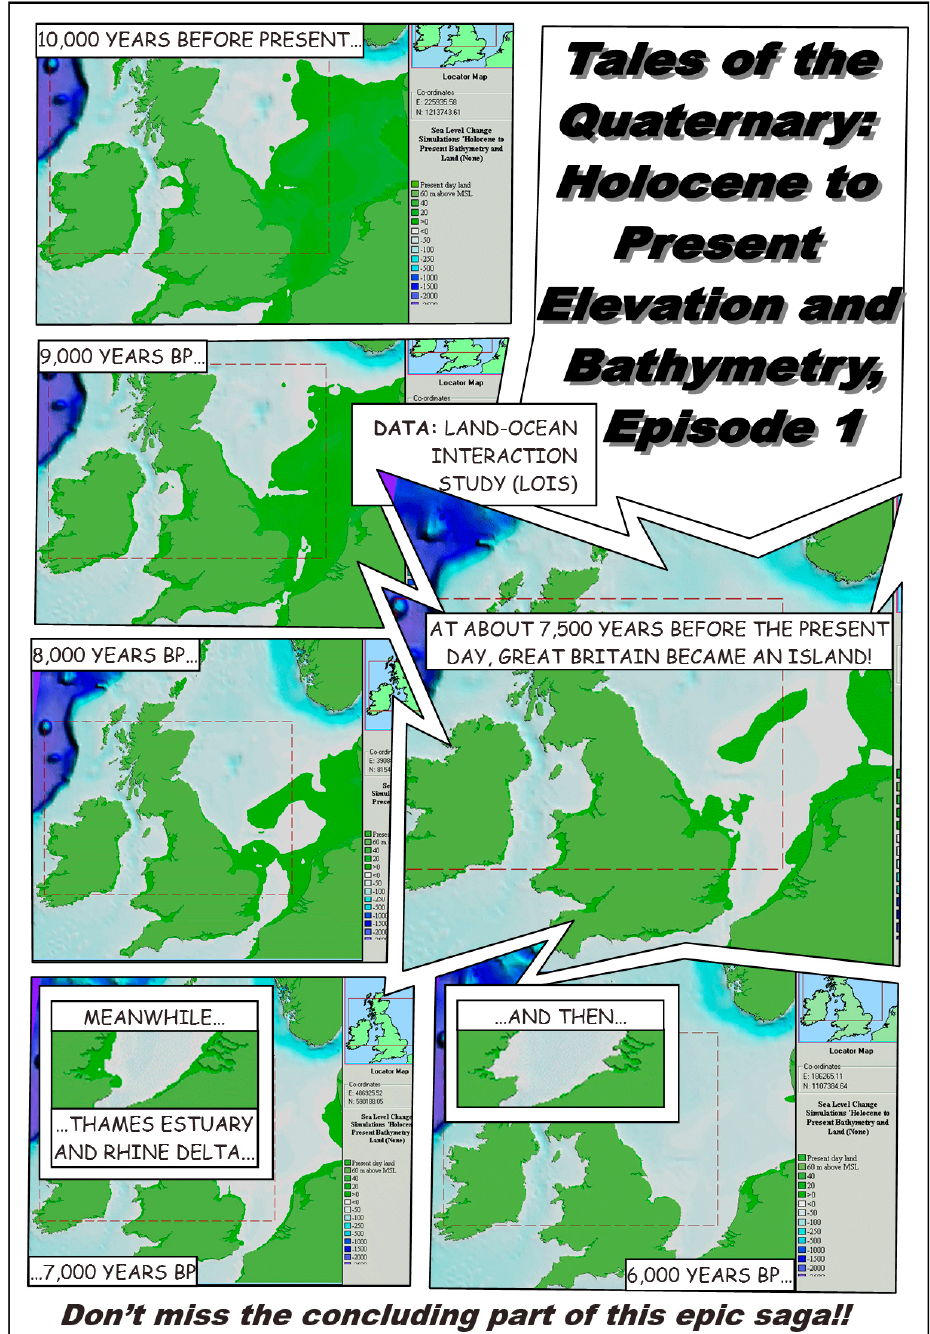
Figure 8. Spatiotemporal snapshots as a comic strip. This sequence expressively uses panels and text, meta-panels and closure to depict sea level rise in a stimulating way, introducing dramatic tension. Data from [75,76].